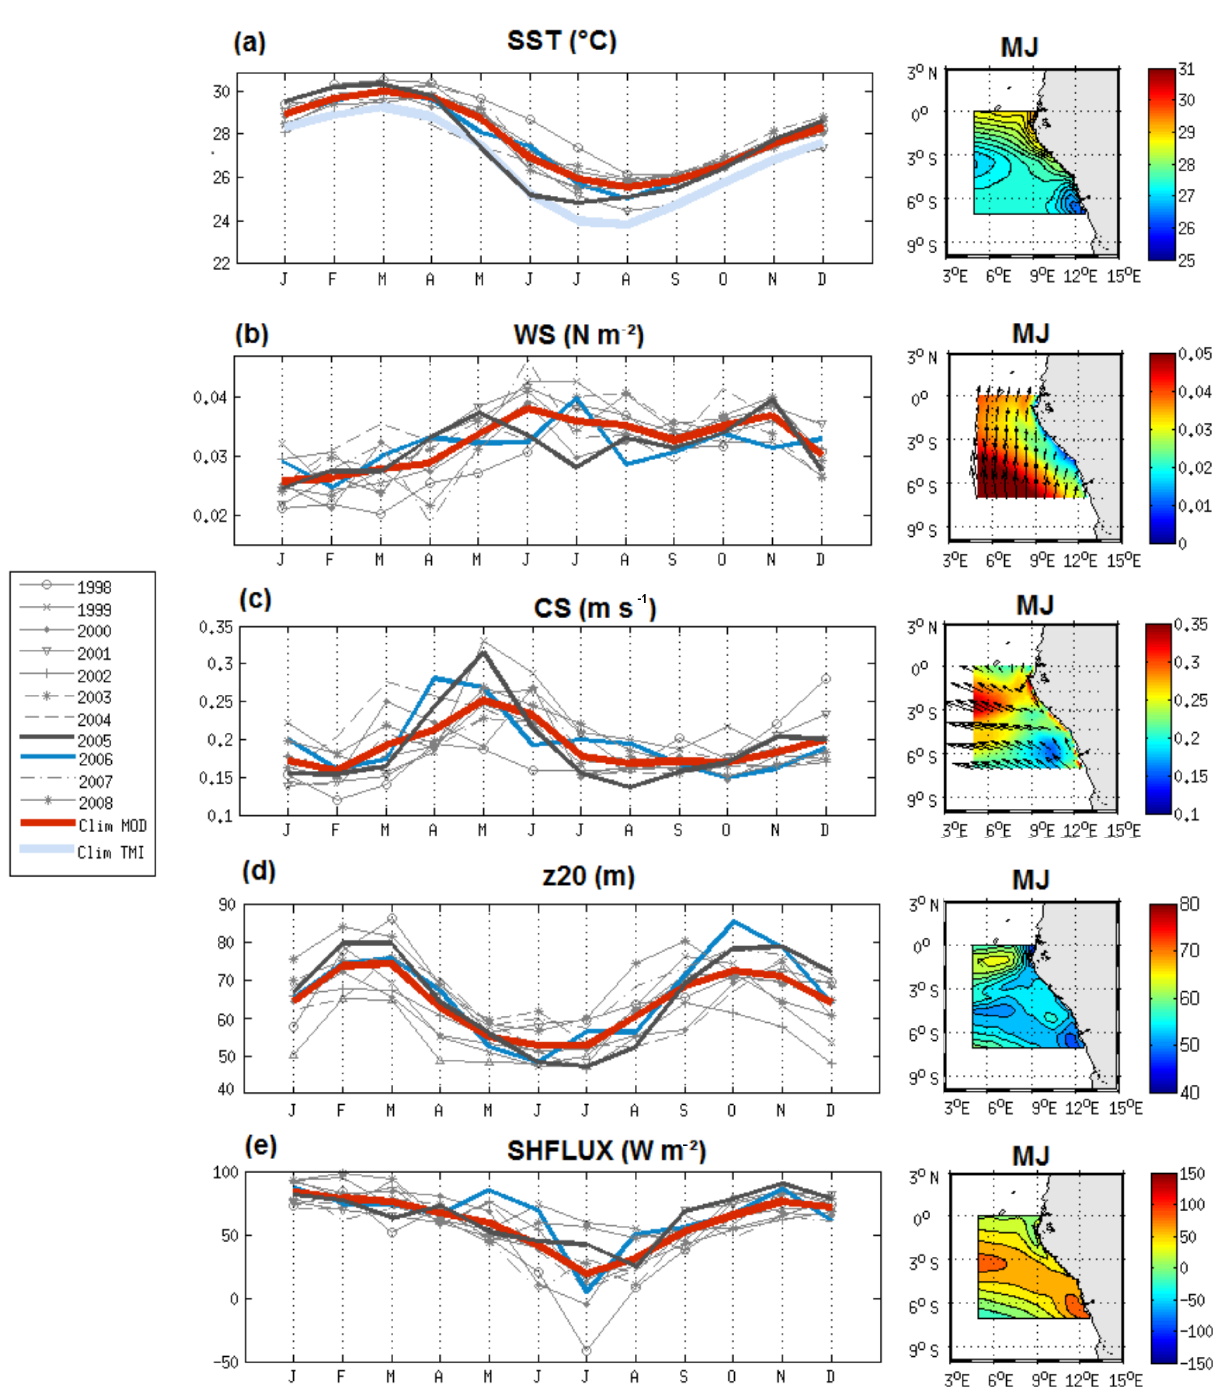
Figure 1. Monthly average of (a) sea surface temperature ( ◦ C), (b) wind stress direction (vectors) and magnitude (color field) (Nm − 2 ), (c) horizontal surface current direction (vectors) and speed (color field) (ms − 1 ), (d) 20 ◦ C isotherm depth (m), and (e) surface heat flux (Wm − 2 ; positive values indicate downward flux) from January to December 1998 to 2008 and for the climatology (averaged over 1998– 2008) simulated by the model (red curve) and from the observations; monthly average TMI 3-daily SST data (light blue curve in a ) averaged over 5–14 ◦ E and 7–0 ◦ S. Right panels: maps of each variable over